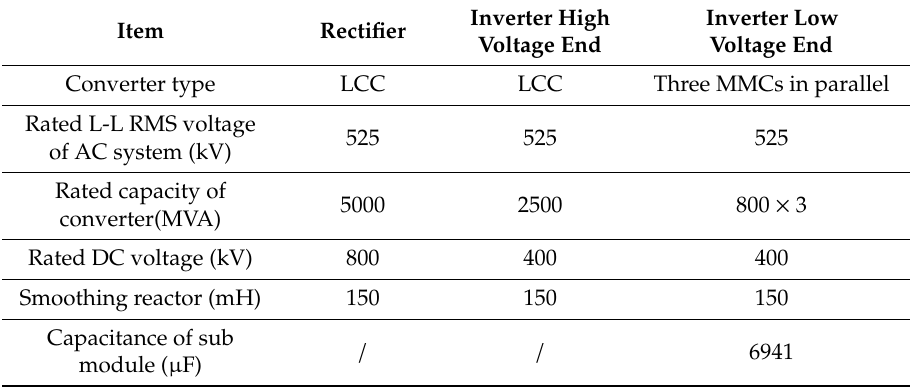
Figure 7. Unipolar topology of the decentralized hybrid system with three modular multilevel converters (MMCs). Table 1. Parameters of the Decentralized Hybrid HVDC System with Three